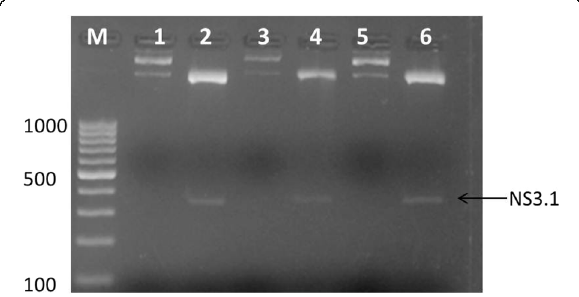
Fig. 5 Restriction and digestion analysis of pet28a vector expressing NS3.1 antigenic sites. Lanes 1, 3, and 5: uncut vectors; lanes 2, 4, and 6: positively NS3.1-digested plasmids; M: 100 bp